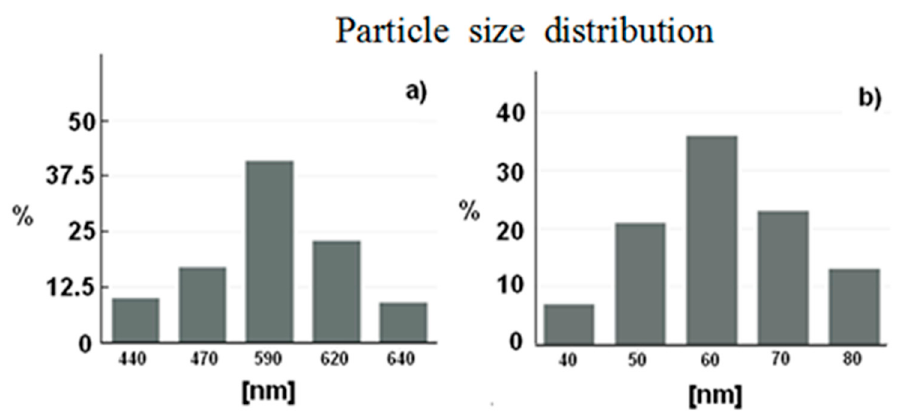
Figure 2. ( a ) Particle size distribution of sulfur particles produced by precipitation from colloidal solution;( b ) particle size distribution of sulfur particles produced by SDR.